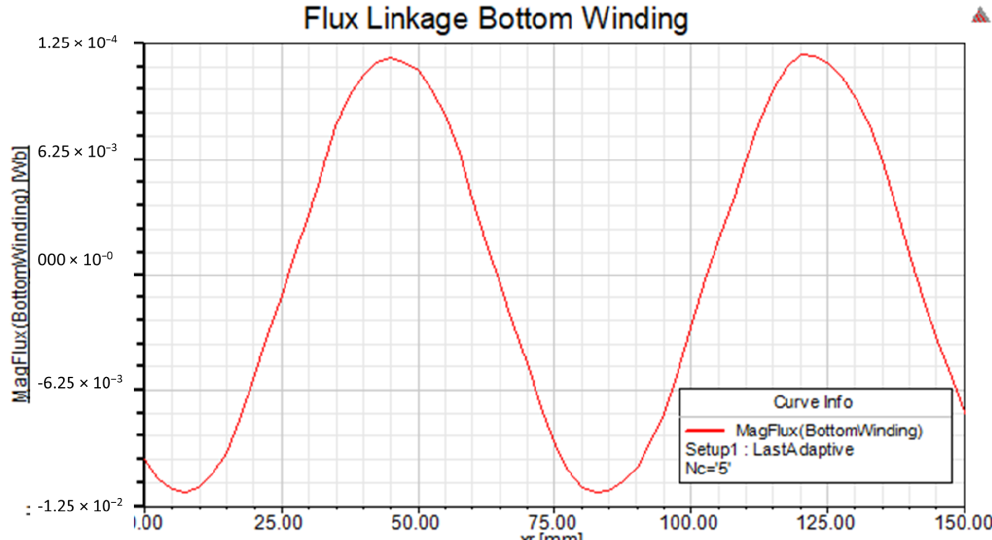
Figure 15. Linkage flux to bottom coil due to excited rotor movement.